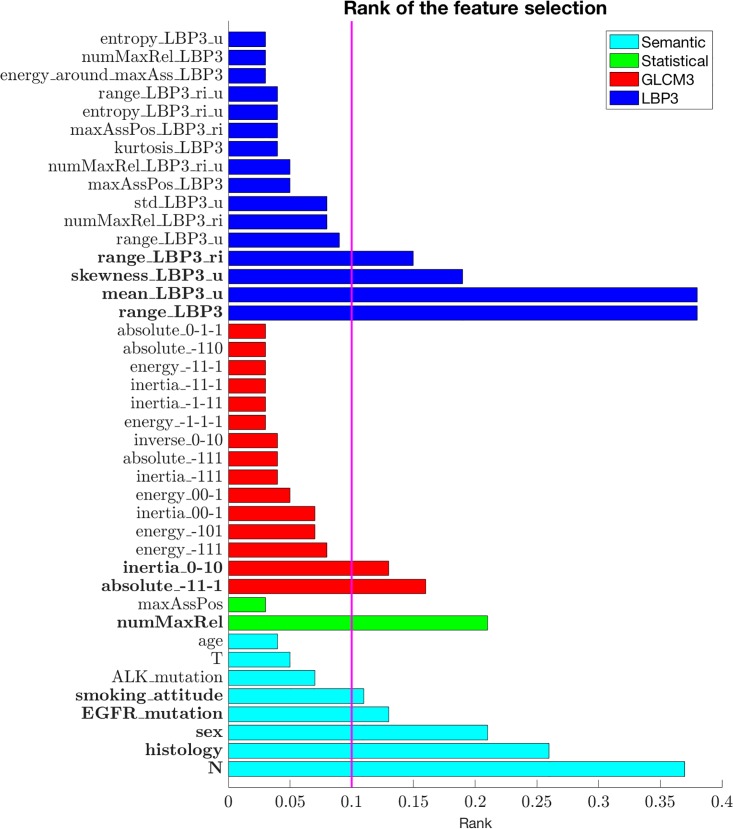
The chart shows the occurrence percentage of each feature obtained during the feature selection procedure.Due to the limited space, we report only those features selected in more than the 3% of the folds of the feature selection procedure for a total of 41 features. Moreover, we highlighted in bold style the names of the descriptors constituting the final signature. The different colors in the histogram represent the different features, as explained in the legend in the upper right corner, whilst a vertical line indicates the threshold used for defining the final signature.